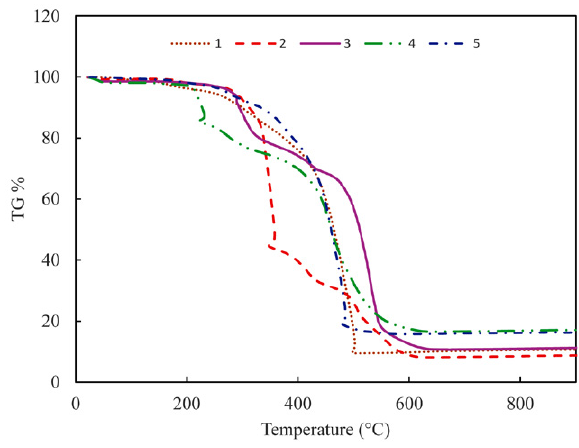
Figure 8: TG curves of the complexes ( 1-5 Table 6. Thermal analysis data of the complexes. Comp. Decom.